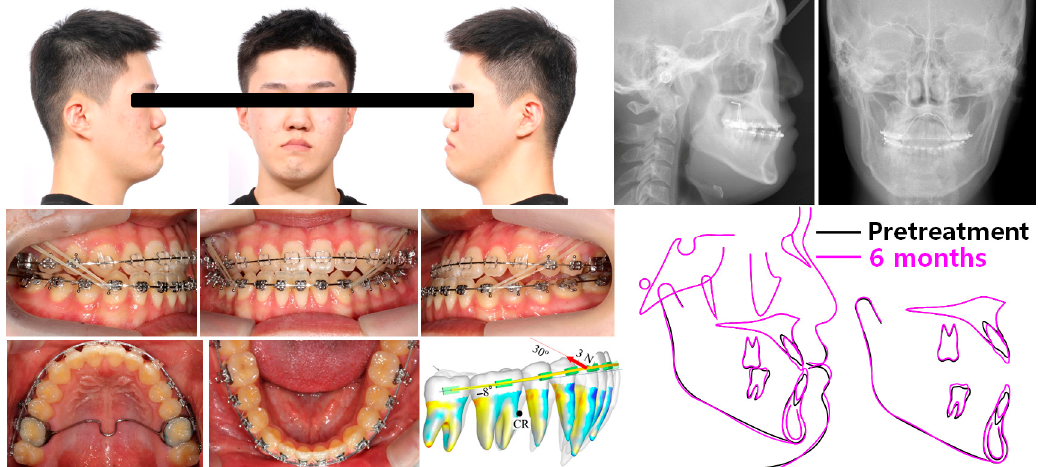
Figure 6. Treatment progress (6 months) photographs, schematic diagram of biomechanics, and cephalometric radiographs and superimposition.